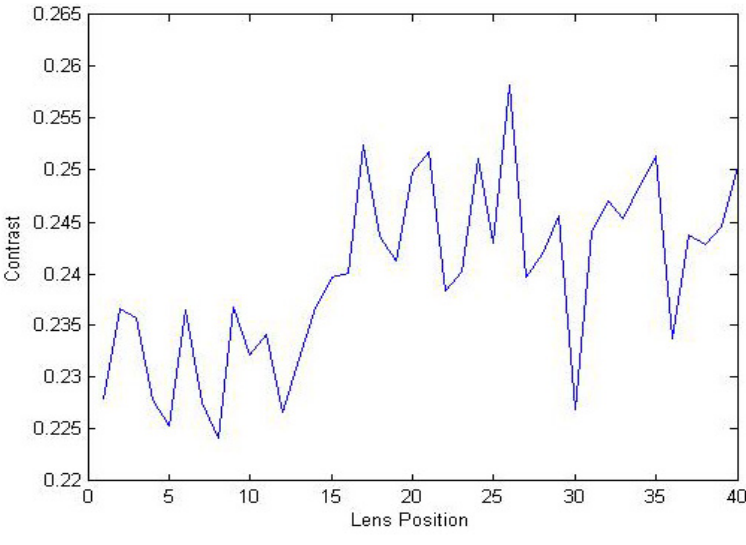
Figure 3. Influence of noise on the shape of a low contrast